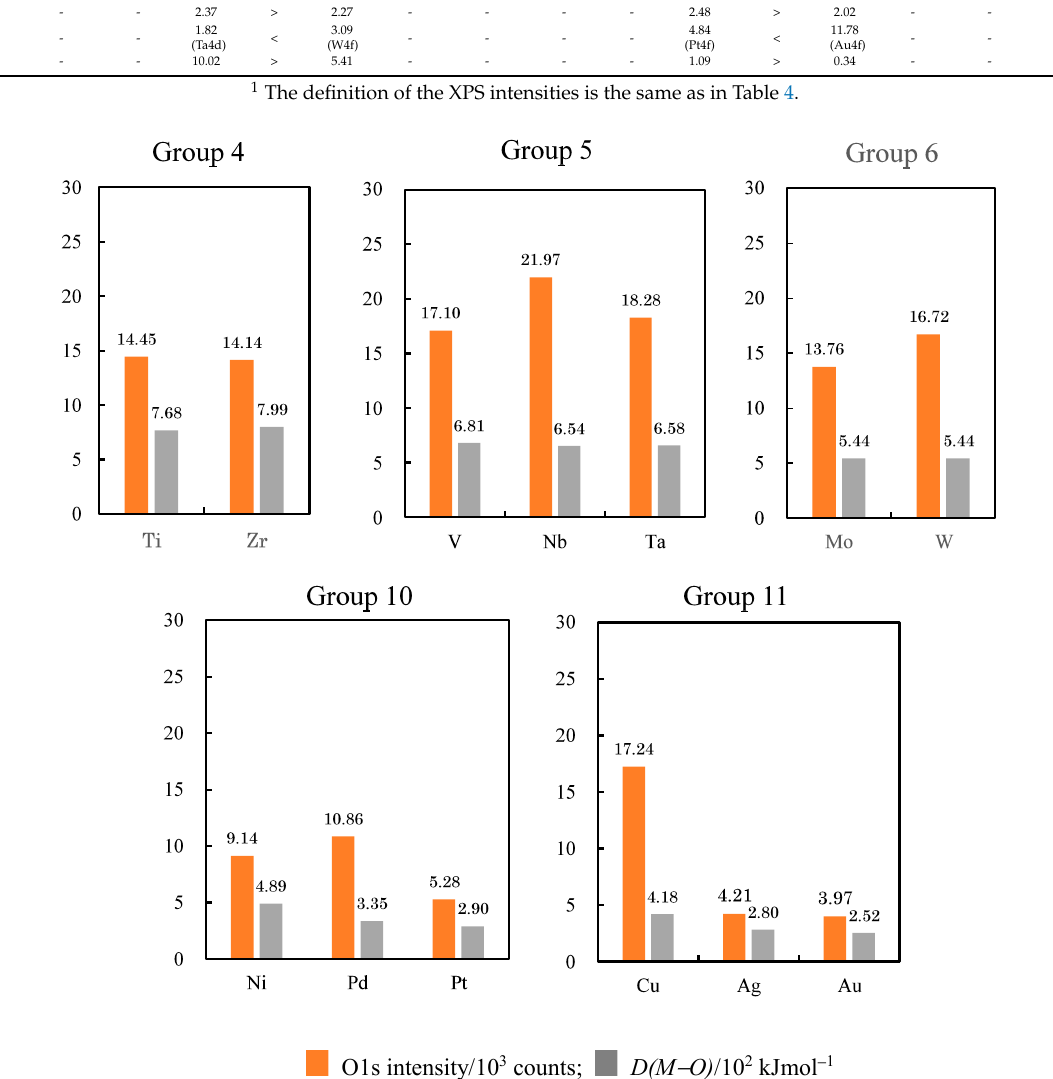
Figure 17. The relationship between D(M–O) values and XPS intensities of O1s before TriboEE measurement for metals in groups 4, 5, 6, 10, and 11.